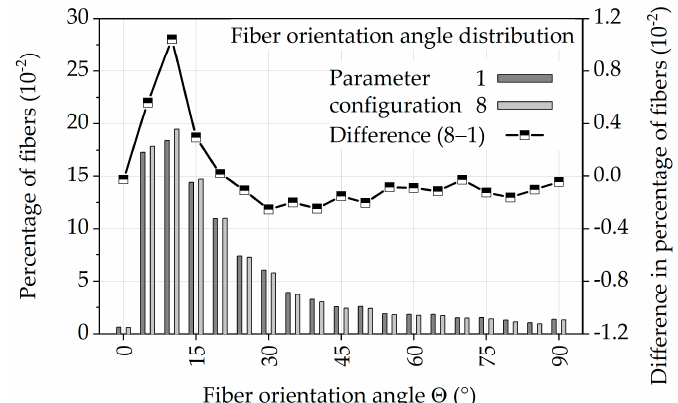
Figure 15. Normalized distribution of fiber orientation with angle Θ (theta) of specimens with parameter configurations 1 and 8.